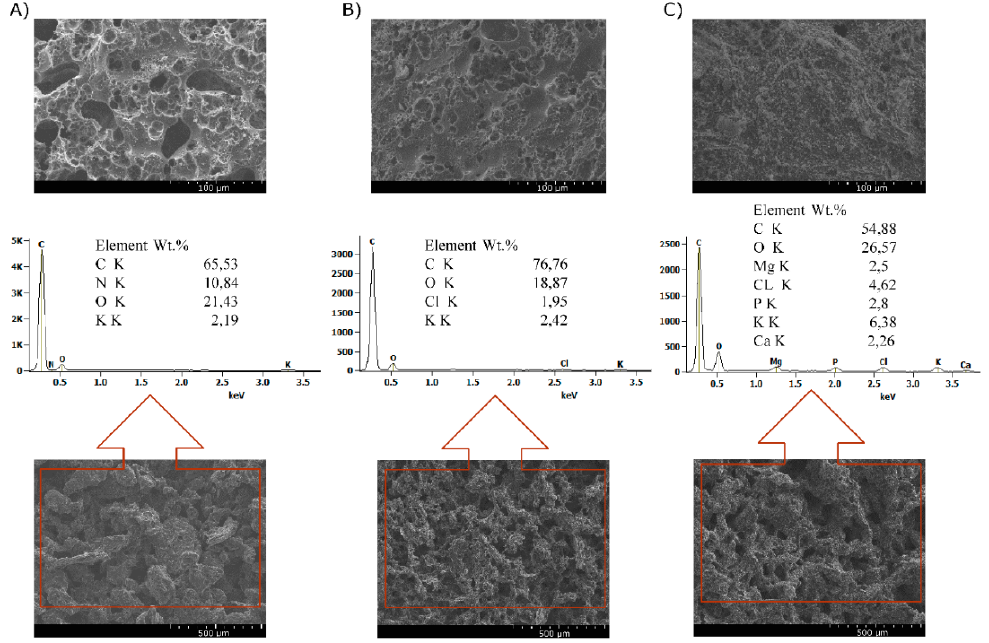
Figure 10. SEM images of the char residue of 35 wt % WS ( A ), 35 wt % HS ( B ), 35 wt % SH ( C ) (top—magnification ×500 and bottom—magnification ×100).